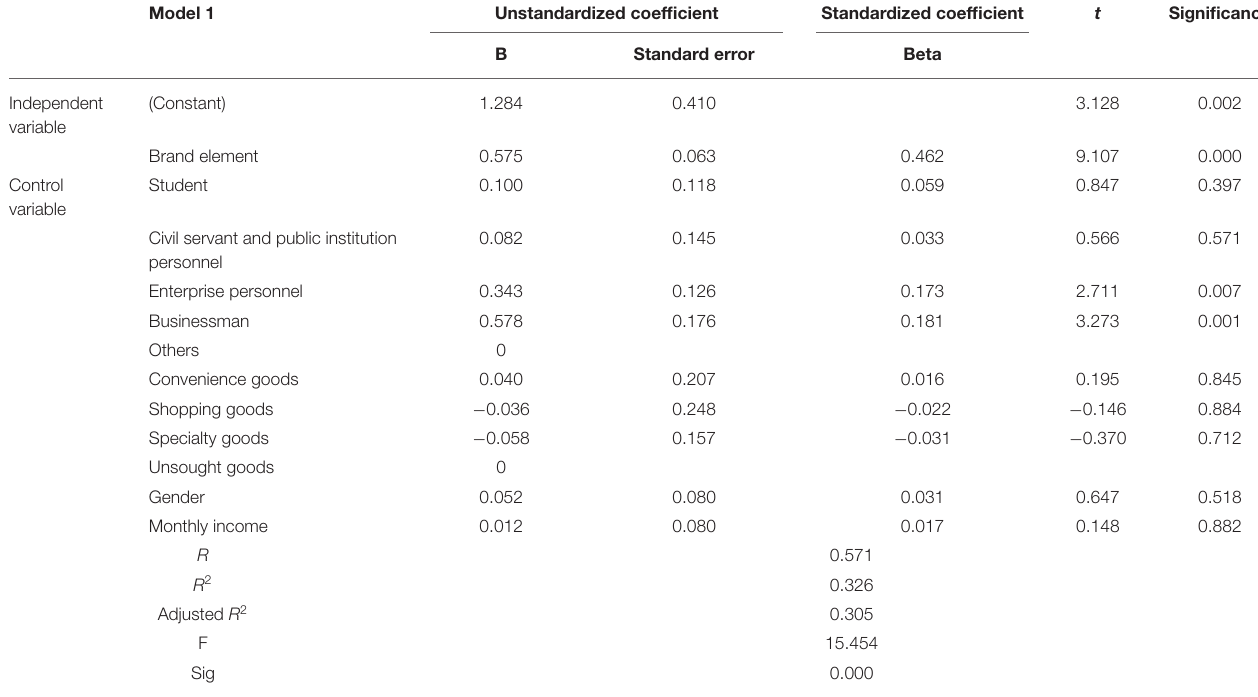
TABLE 2 | Regression analysis of brand elements to consumers’ purchase